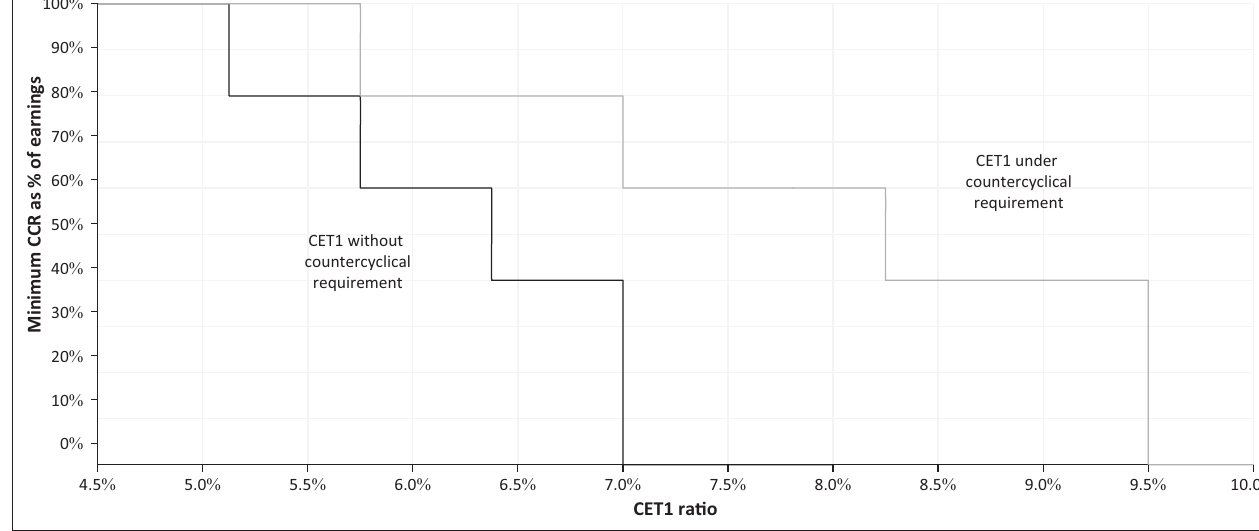
FIGURE 2: Proposed Basel III countercyclical